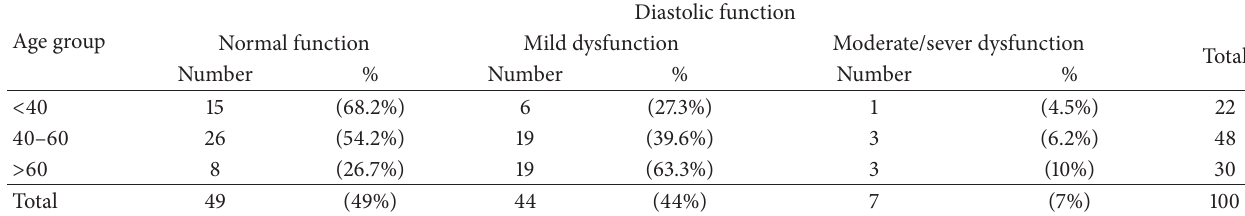
Table 5: Distribution of diastolic function in various age